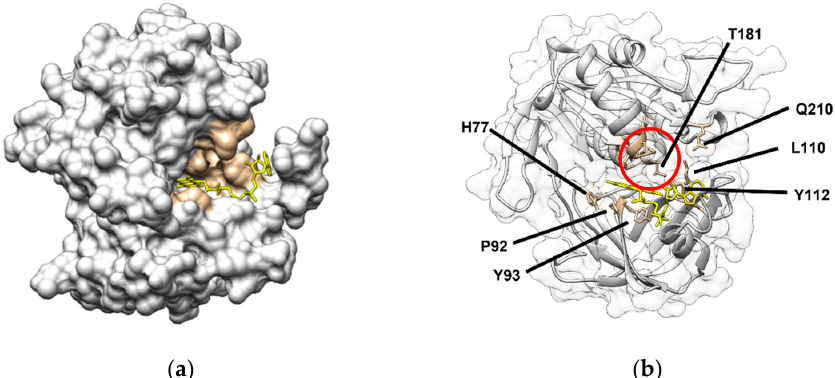
Figure 2. FAD protruding site of C b 5 R (PDB: 1UMK) and residues involved in NADH binding. Surface representation of the human C b 5 R structure obtained by crystallography (PDB:1UMK) and location of the FAD (represented as yellow sticks) protruding site is shown in panel ( a ). Residues interacting with the diphosphate groups and the adenine ring of NAD + , as reported, are labeled in brown. The same representation is shown in panel ( b ), where the surface is transparent, and the residues interacting with NAD + (brown), and the backbone can be viewed (grey). The red circle labels the 273 CGPPPM 278 motif, which forms the NAD + -binding surface.